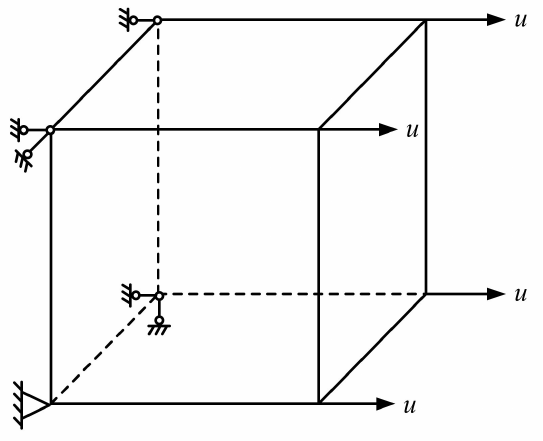
Figure 10. Schematic diagram of finite element